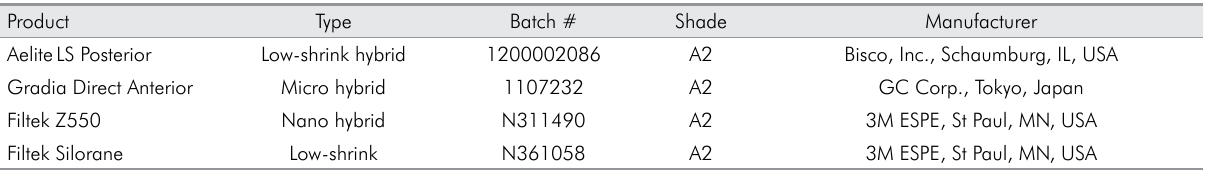
Table 1. Composite Resins Used in the Current Study.